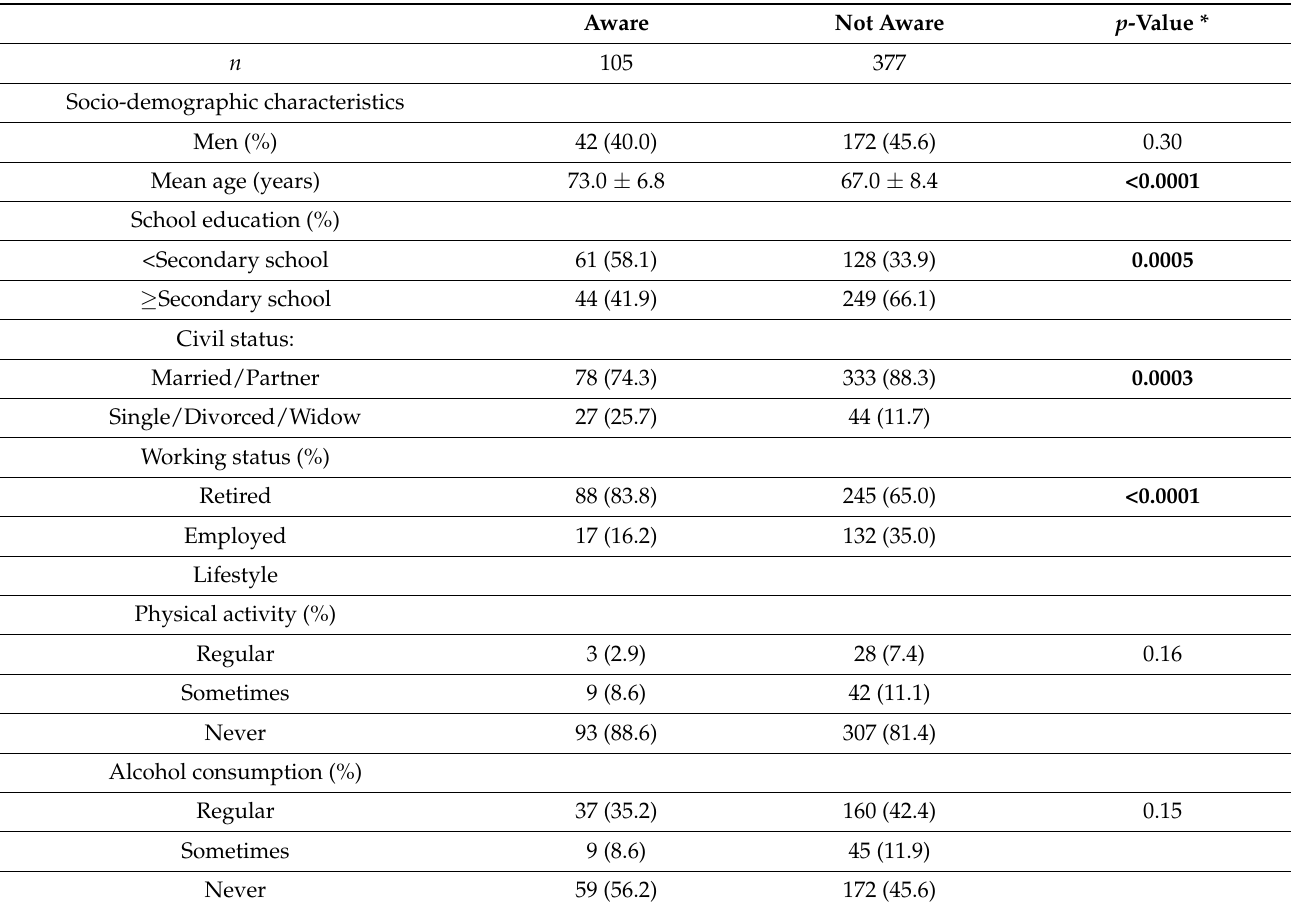
Table 3. Subgroup of patients with cataract ( n = 482) and their characteristics by awareness about their cataract. Aware Not Aware p -Value * 105